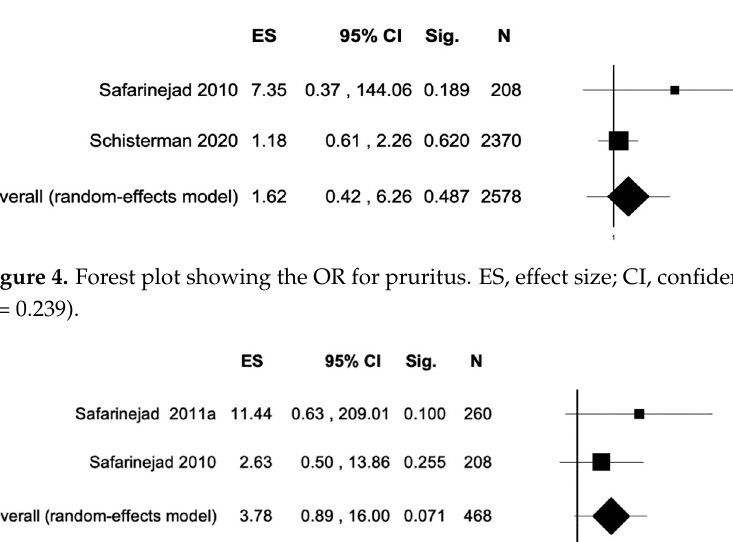
Figure 3. Forest plot showing the OR for headache. ES, effect size; CI, confidence interval. (I2 = 0.00, p = 0.823).